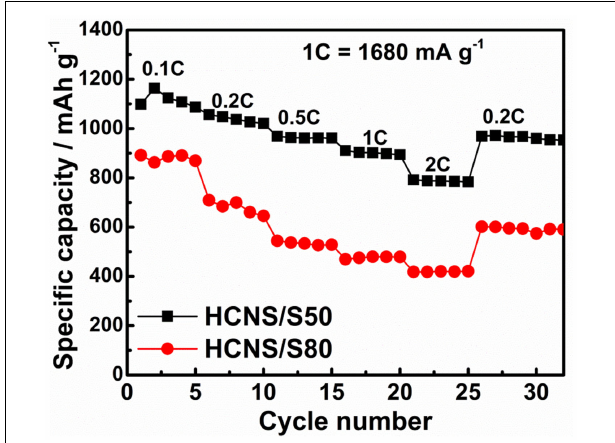
FIGURE 6 | Rate performance of HCNS/S composites with different sulfur loading (1 C = 1680mAg (cid:0) 1 ) . LIBs,whichdeliversthehighestgravimetricenergydensity among